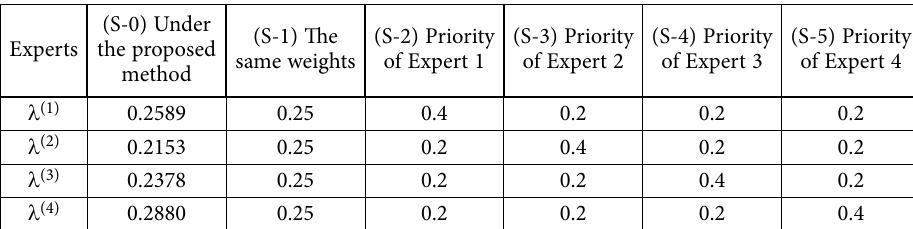
Table 13. Experts’ weights assignment (S-0) Under Experts the proposed